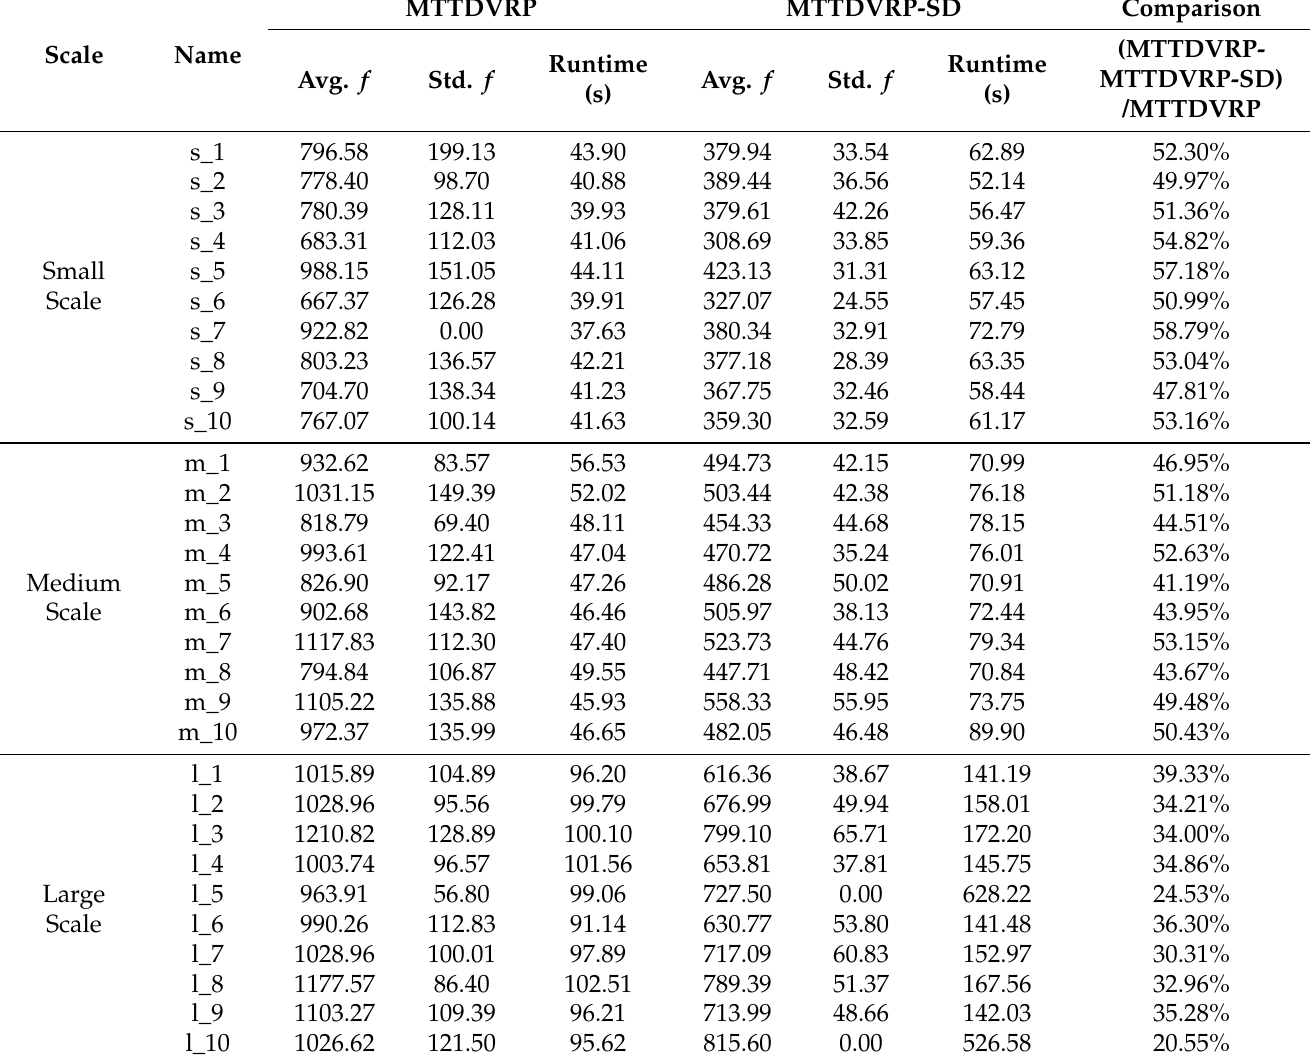
Table 4. Results of comparing the two models under three scale